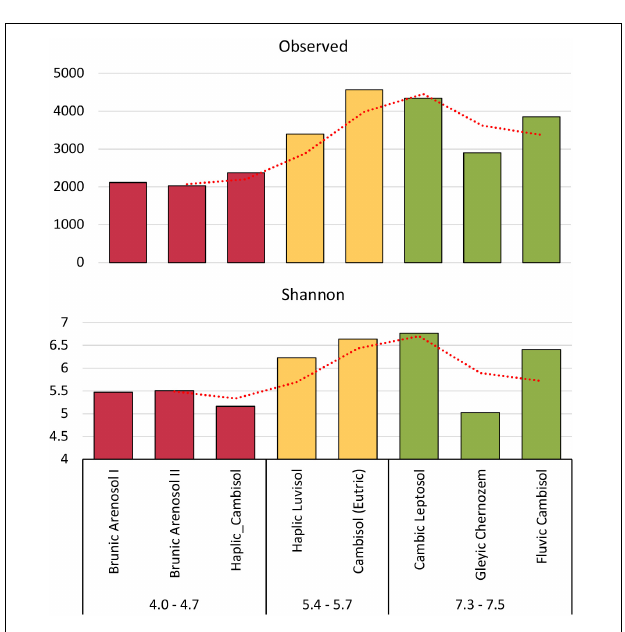
FIGURE 3 | Shannon’s H’ and observed biodiversity indexes of fungal communities, based on total Amplicon Sequence Variants